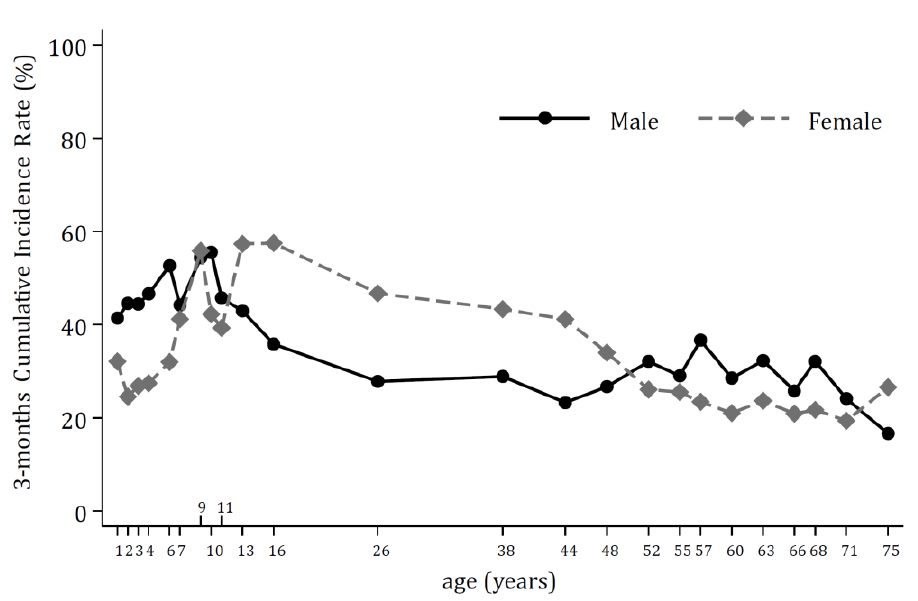
Figure 4. Subpopulation Treatment Effect Pattern Plot (STEPP) of the 3-month cumulative incidence rate of the reported symptoms in males (solid black line) and females (dotted grey line). The plot was drawn adopting the sliding window pattern, including n = 100 subjects in each subpopulation and n = 75 subjects in common among consecutive subpopulations, implementing 2500 permutations of the covariate age.